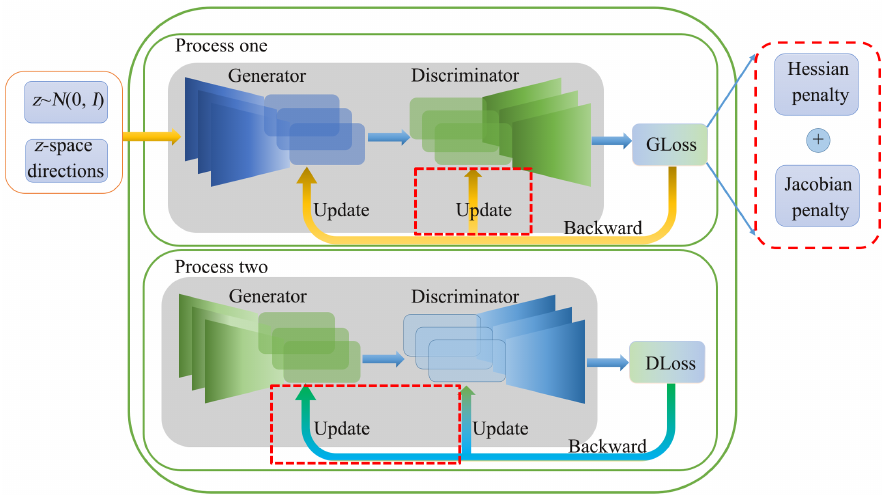
Figure 1. Structure of the network